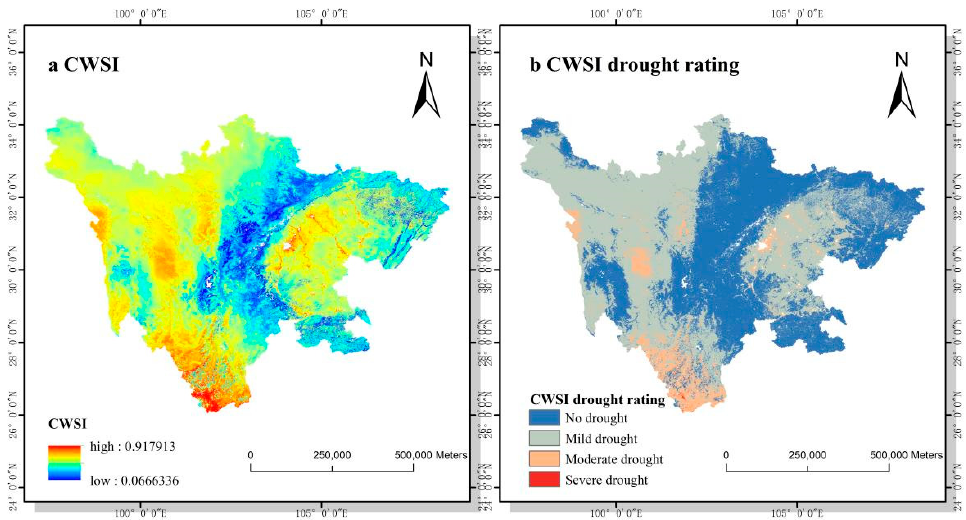
Figure 7. Trend of drought based on CWSI in Sichuan Province from 2001 to 2020.